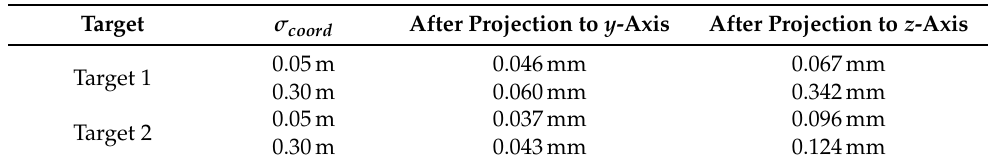
Table 3. Measurement uncertainty of the projected displacements considering the uncertainty of the target coordinates σ coord